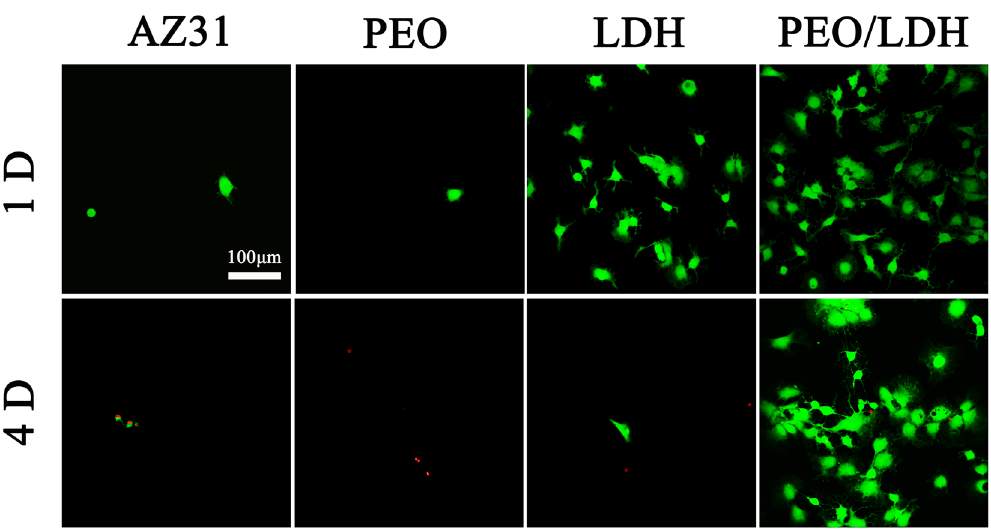
Figure 9. CLSM images of live/dead staining of cell after culturing on various surfaces for 1 and 4 d (green represent live cells and red represent dead